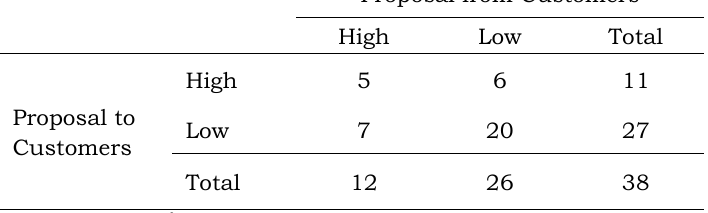
Table 2. Cross table of DC group